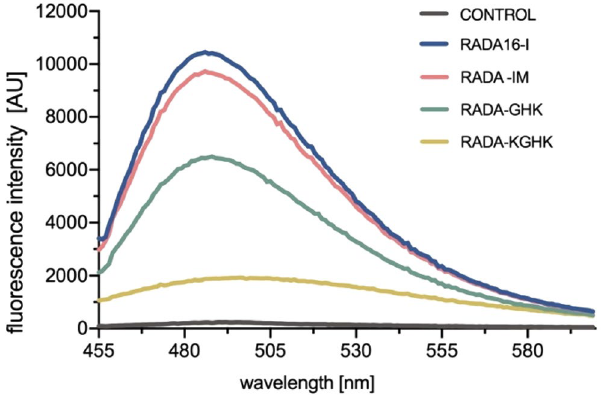
Figure 4. Thioflavin T test for RADA peptide hybrids.